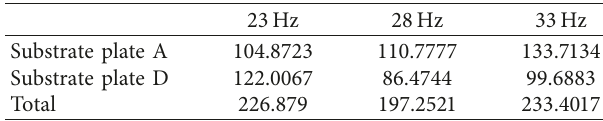
Figure 10: Voltage in time history and the phase portrait of the nonlinear EMM system: (a) voltage-time@23 Hz; (b) phase portrait@23 Hz; (c) voltage-time@28 Hz; (d) phase portrait@28 Hz; (e) voltage-time@33Hz; (f) phase portrait@33Hz. Table 6: Averaged voltage (mV) of the nonlinear EMM system in 100